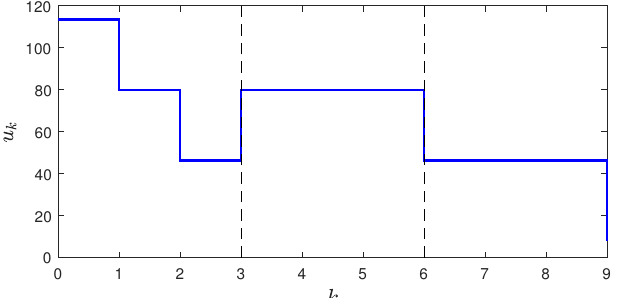
Figure 9. Control sequence using move-blocking strategy, where k b = 3 and N = 10. The first three moves are free, then blocked in consecutive blocks of three controls. Note that N b = 6, k r = 1, and the last control is within a separate block from k = 9 to k = 10.